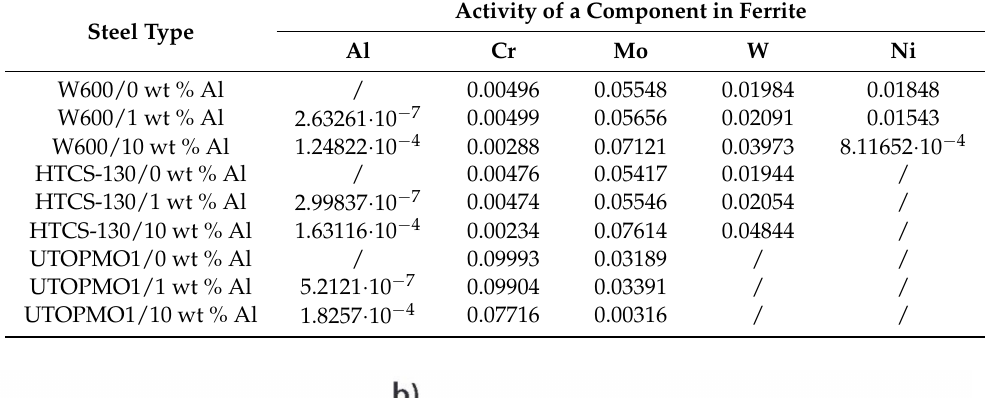
Table 2. Activity of alloying elements in the investigated tool steels with different contents of aluminum (0, 1, and 10 wt %).